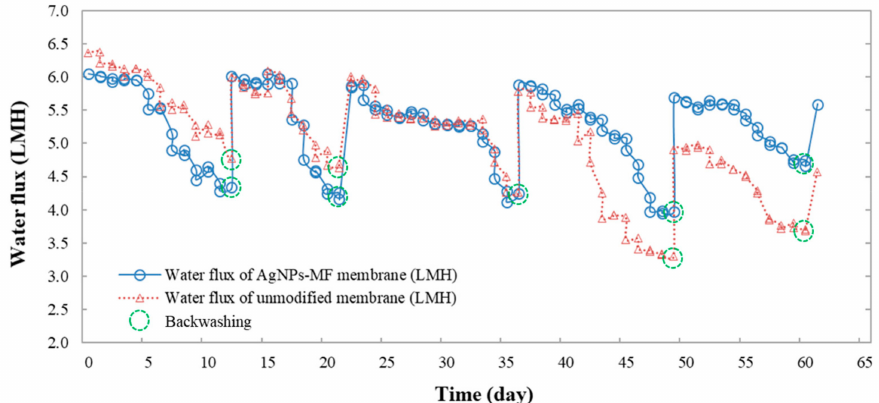
Figure 4. The comparative study of permeate flux of the unmodified membrane module and the AgNPs-MF membrane module over the 60-day operation period.